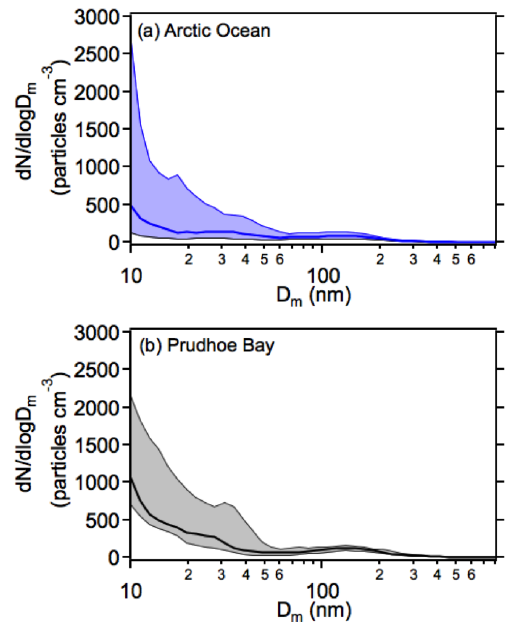
Figure 3. Particle number distributions (10–810nm mobility diam- eter) for (a) Arctic Ocean and (b) Prudhoe Bay air masses observed for August–September 2008, 2009, 2013, and 2014 (median shown by the solid line; 25th and 75th percentiles shaded) at the NOAA Barrow